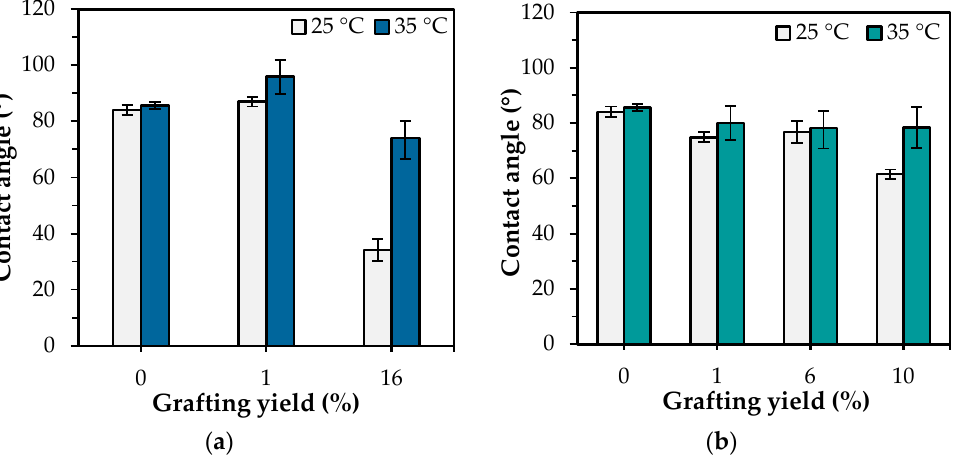
Figure 5. Water contact angles of ungrafted and PNIPAm - grafted nylon film with different grafting architectures ass a function of grafting yield at 25 and 35 °C : ( a ) linear; ( b ) crosslinked structures .